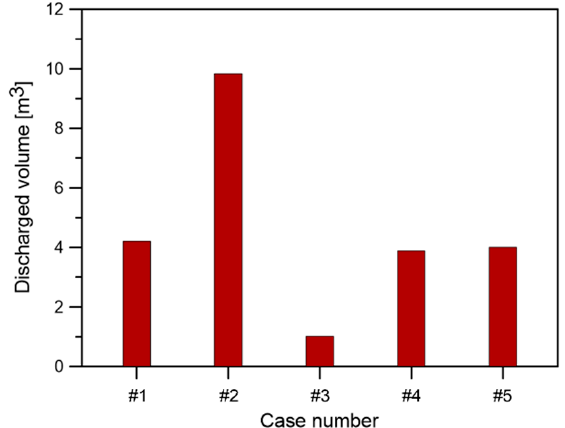
Figure 15. Comparison of discharged volume after the EPB shield has advanced 300 mm.